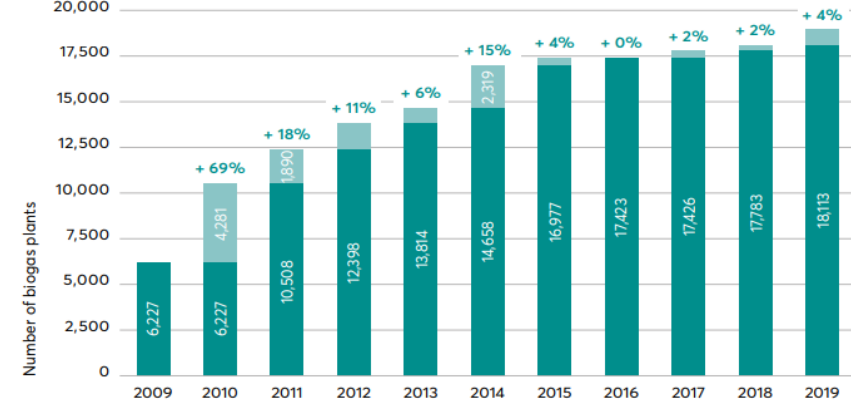
Figure 1. Development of the number of biogas plants in Europe, 2009–2019 [45].